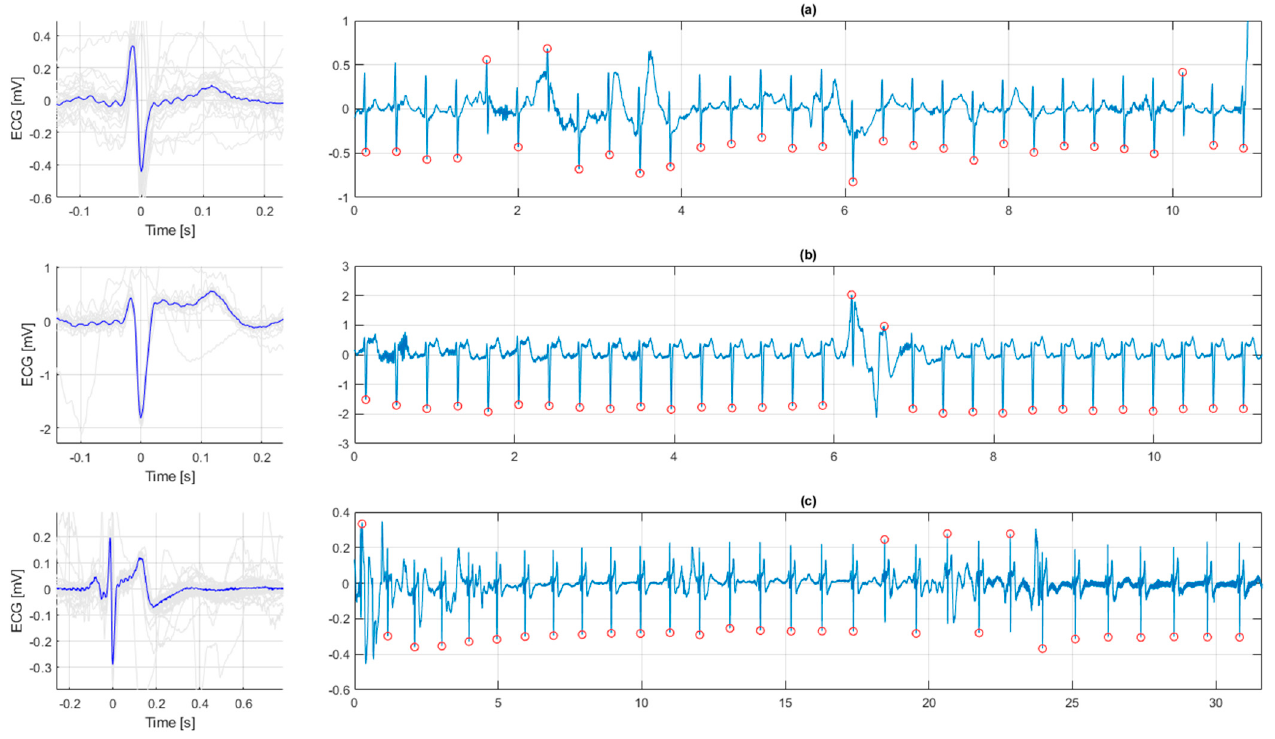
Figure 3. Examples of ECG morphologies. ( a ) Normal ECG. ( b ) ST elevation. ( c ) A biphasic ST ‐ segment. Left in Figure 3a–c are the medians of all complexes aiding the visual analysis.